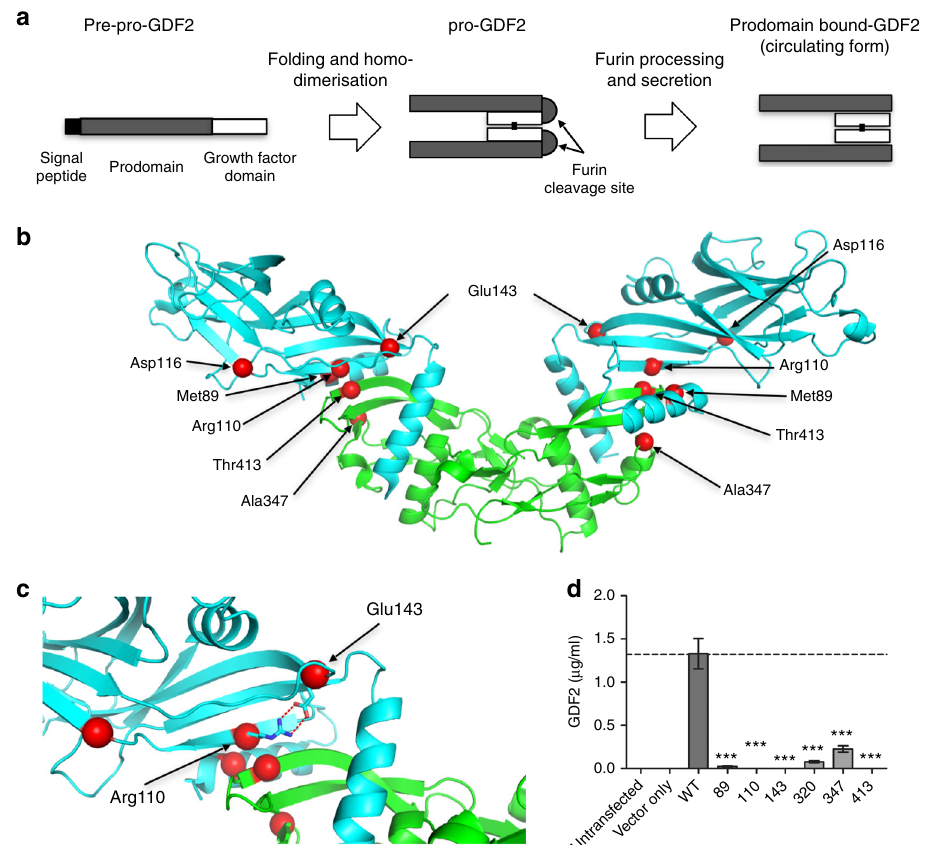
Fig. 5 Structural analysis of GDF2 mutations. a Schematic diagram of GDF2 processing. The pre-pro-protein is processed into the mature growth factor domain (GFD) bound to the prodomain upon secretion 61 . b Plot of GDF2 mutations found only in PAH cases superimposed on the structure of prodomain bound GDF2 (PDB: 4YCG) 21 . The GDF2 growth factor domain is shown in green and the prodomain in cyan. c Magni fi ed view of the Arg110 and Glu143 mutations. The wild-type amino acids make double salt bridges to stabilise the prodomain conformation at the interface between the growth factor domain and prodomain. The E143K and R110W mutations both disrupt these interactions, destabilising the interaction between the growth factor domain and prodomain. d GDF2 levels secreted into supernatants of HEK293T cells transfected with likely pathogenic variants found in PAH cases, compared with wild-type GDF2 and cells transfected with an empty vector. *** P < 0.001 by